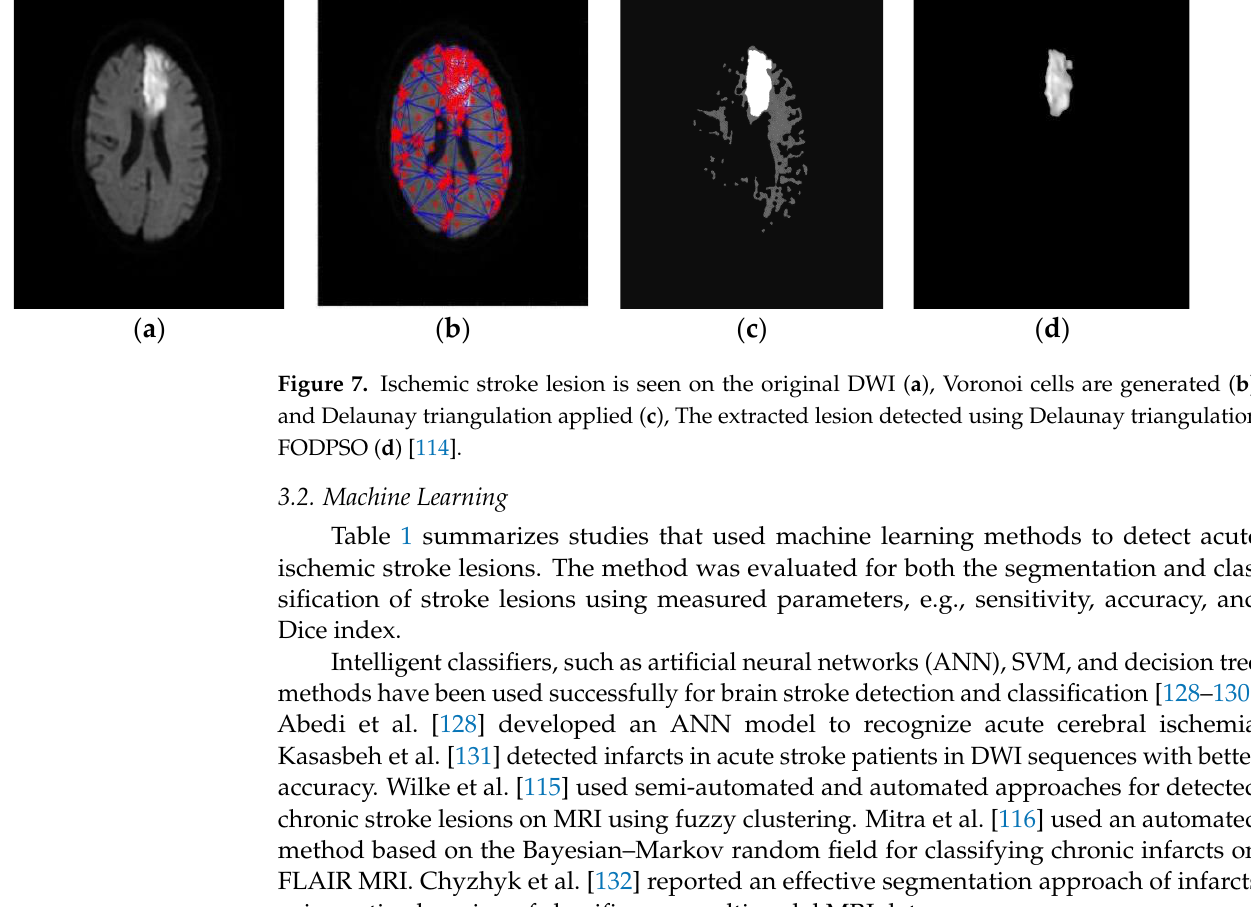
Figure 6. Large ischemic stroke lesion is seen on the original DWI ( a ), with lesion detected using PSO ( b ) and fractional-order DPSO ( c ) [99].